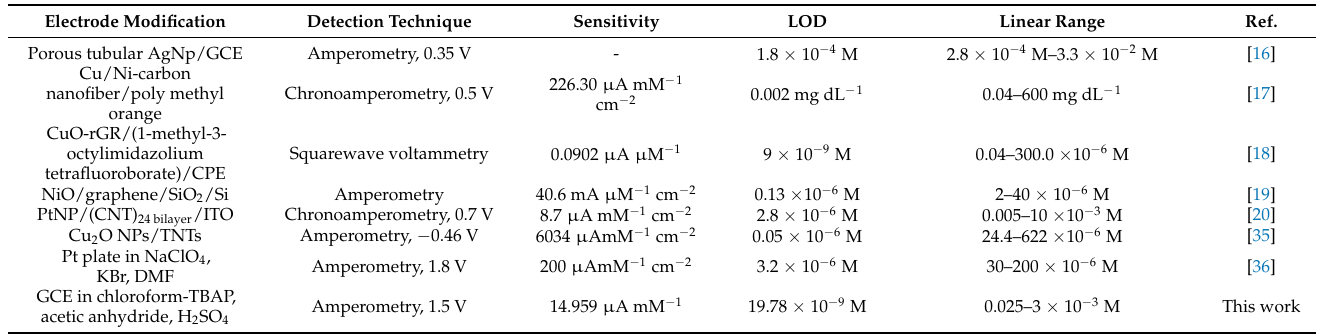
Table 2. Analytical parameters of different non-enzymatic detection of cholesterol compared with proposed method in this work.